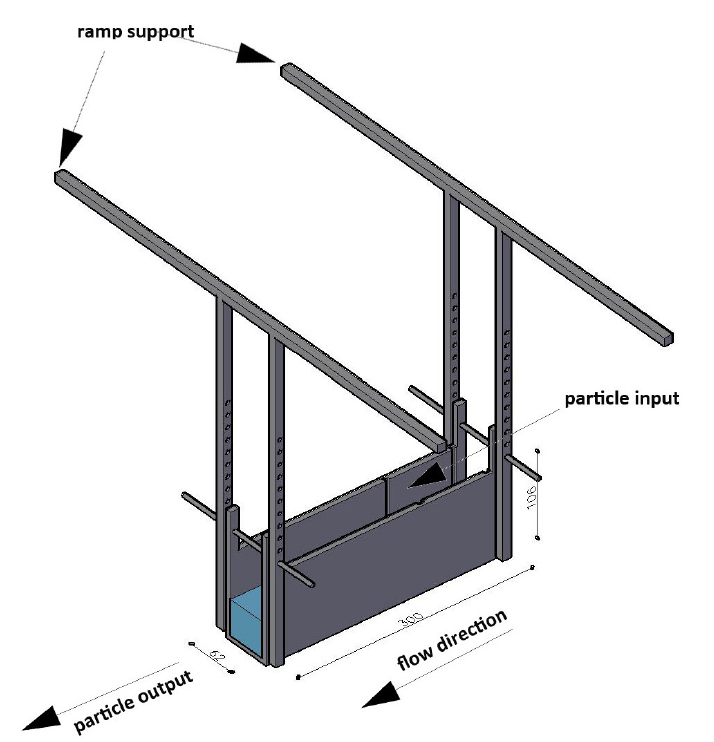
Figure 2. A 3D sketch of dosing ramp used for inserting particles into water stream (dimensions in mm).